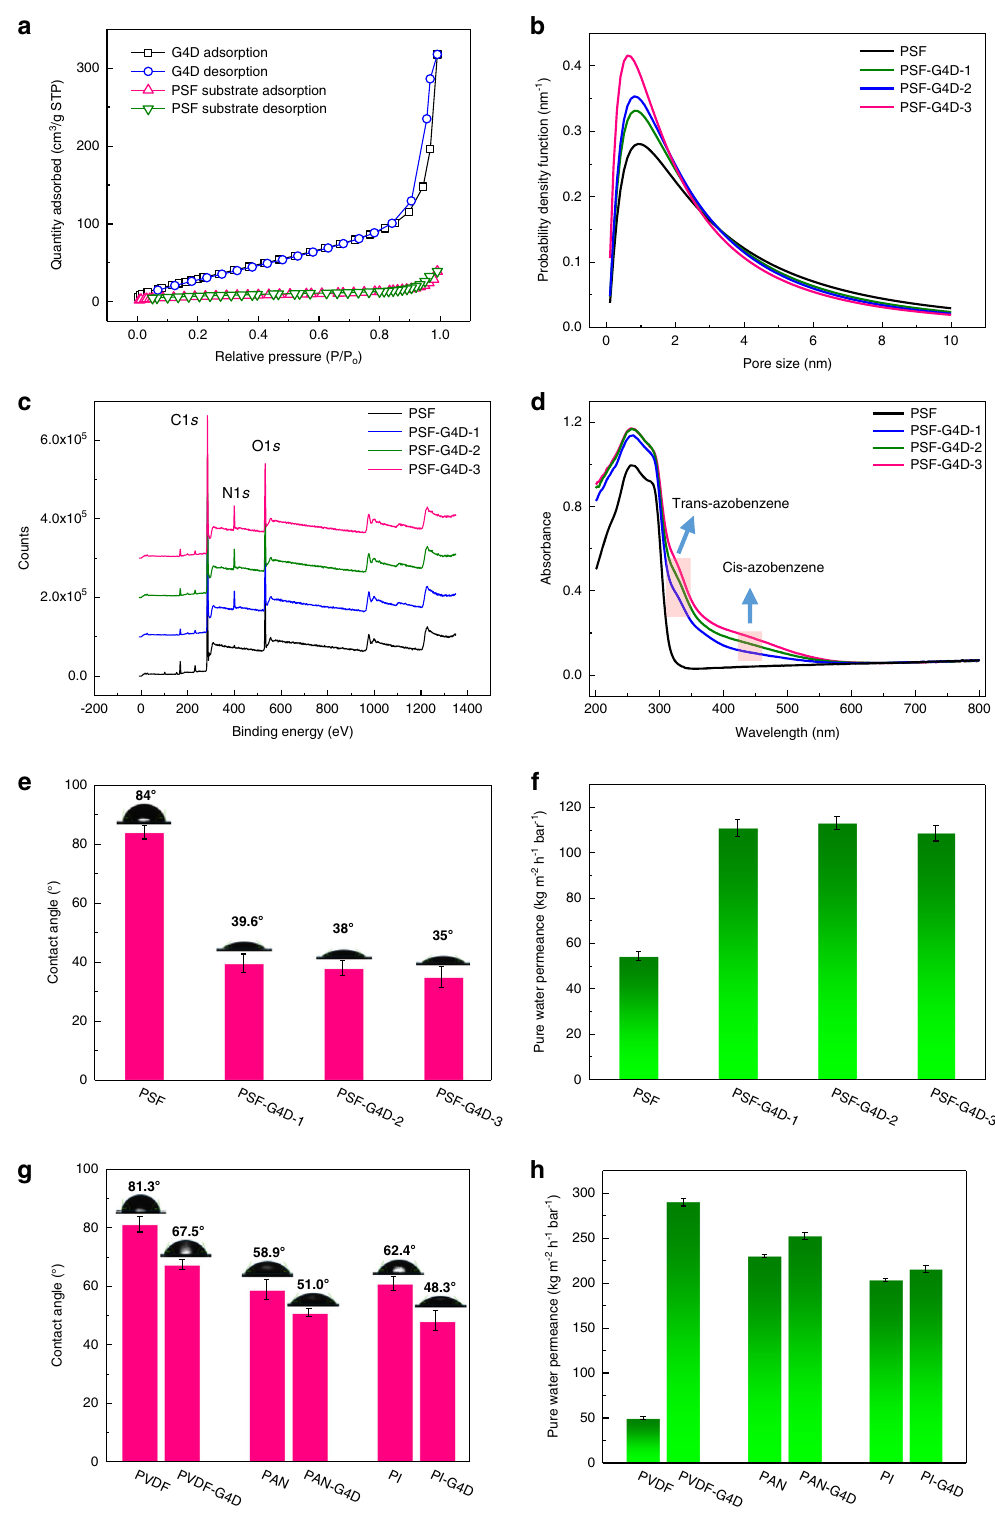
Fig. 3 Structure characterizations and pure water permeance tests. a N 2 sorption at 77 K for the G4D and the pristine PSF substrate. b Calculated pore size distributions averaged over the pristine PSF and the PSF-G4D membranes. c XPS survey spectra of the pristine PSF, PSF-G4D-1, PSF- G4D-2, and PSF-G4D-3 supports. d UV-visible diffuse re fl ectance spectrum (DRS) of the pristine PSF and the PSF-G4D-1, PSF-G4D-2, and PSF-G4D-3 supports. e , f Contact angles and pure water permeance of the pristine PSF and the PSF-G4D supports. g , h Contact angles and pure water permeance of the pristine and modi fi ed PVDF, PAN, and PI